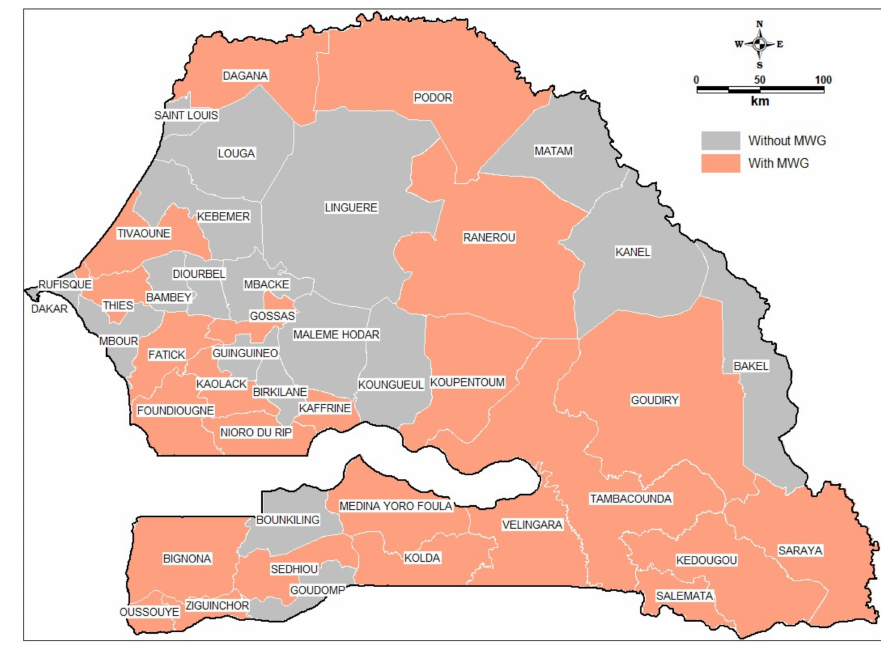
Figure 3. Pictorial representation of the multi-disciplinary working groups (MWGs) created during the study period (source: from